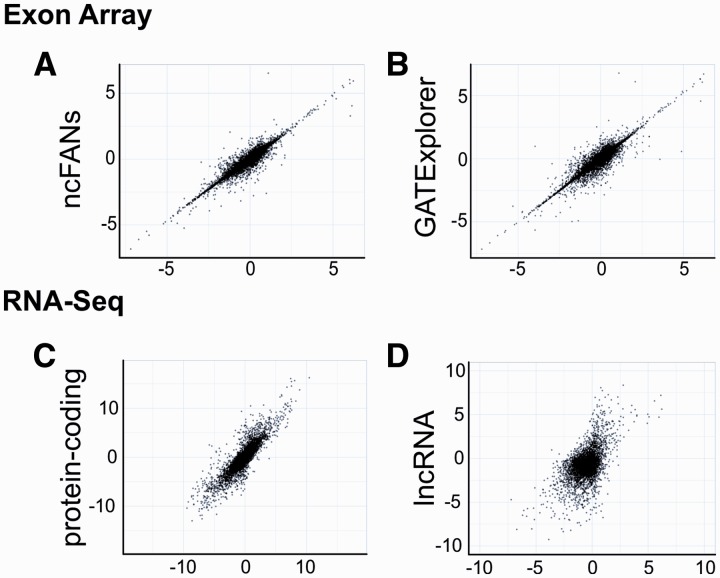
Correlation of the log2 fold changes between the heart and the kidney of the (A) ncFNAs and (B) GATExplorer annotations compared with our lncRNA annotation (x-axis). The Pearson’s correlations are 0.95 and 0.96, respectively. (C) Correlation of the fold changes of protein-coding genes between the heart and kidney measured by RNA-Seq and noncoder (x-axis). The Pearson correlation is 0.87. (D) Correlation of lncRNAs. The Pearson correlation is 0.55.